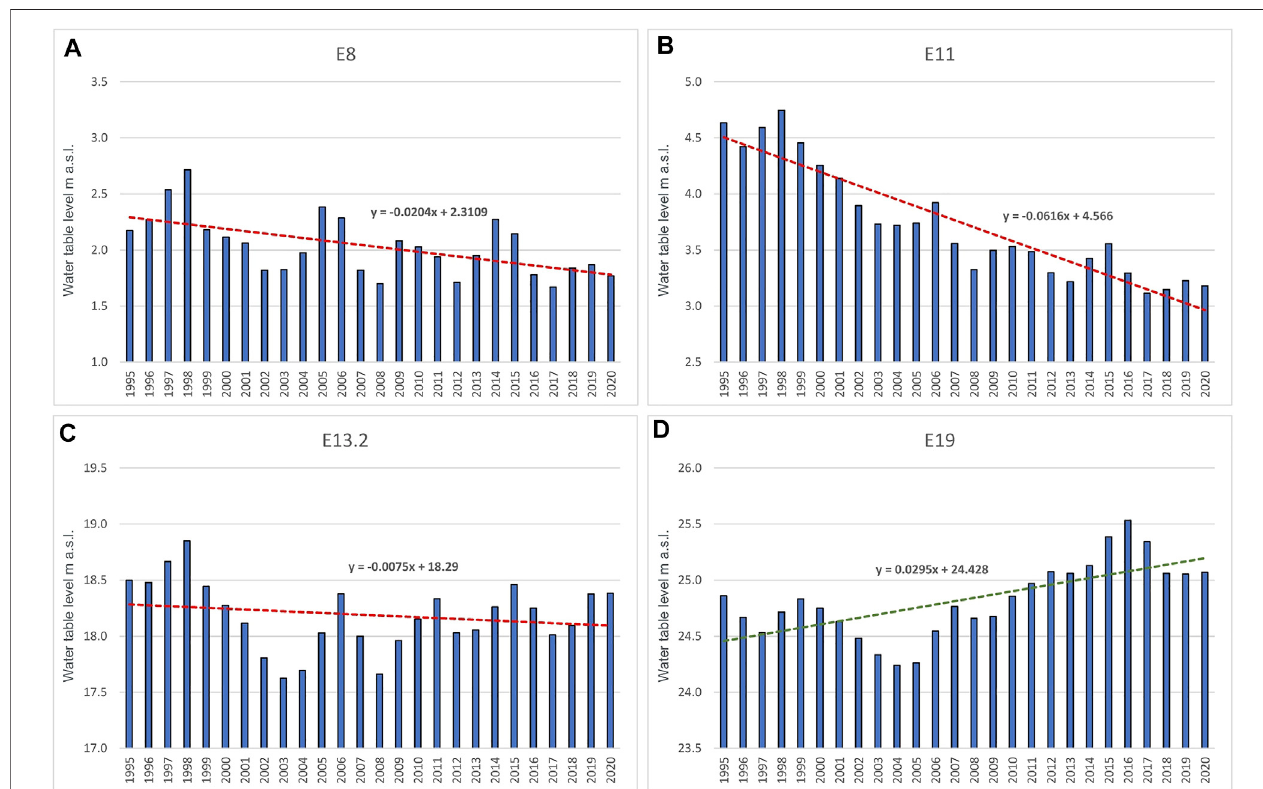
FIGURE 3 | Mean annual water table level trend over time of monitoring wells (see Figure 1 for their location) with related equations: E8 [coastal area, (A) ], E11 [central area, (B) ], E13.2 [northern area, (C) ], and E19 [eastern area, (D) ].